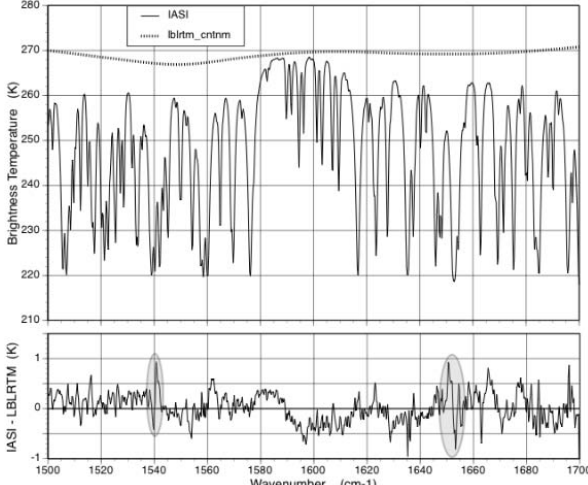
Fig. 19. Top: IASI measured brightness temperatures in the water vapor band for the land case, also showing the contribution from the water vapor continuum in this region. Bottom: IASI-LBLRTM residuals after the retrieval, showing the residual feature in the band center and the residual signature of water vapor line coupling for two pairs of water vapor lines at 1540 and 1655cm − 1